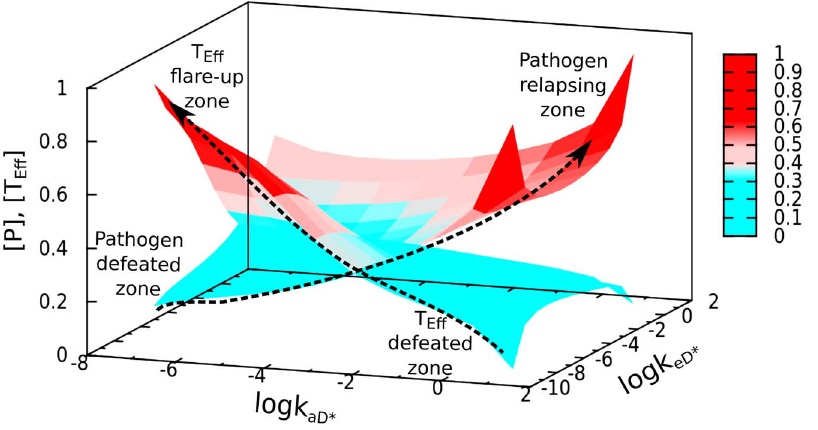
Figure 6. Impact of active vitamin-D over the steady state profiles of pathogen, [P] and effector T-cell, [T Eff ]. (a) We vary simultaneously the impact of active vitamin -D ([D*]) over APCs k aD (cid:2) ð Þ and effector T-cells k eD (cid:2) ð Þ . We find different regions: (i) At low vitamin-D impact k aD (cid:2) * 10 { 8 { 10 { 4